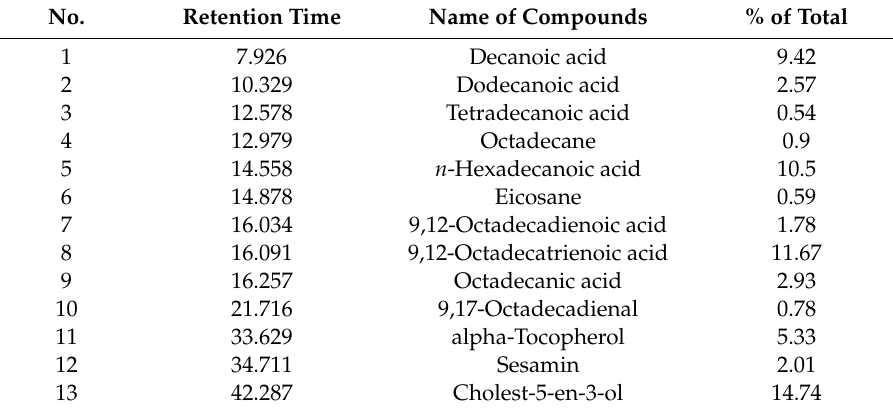
Table 3. Phytochemical compounds identified in H. cordata by using GC-MS. No. Retention Time Name of